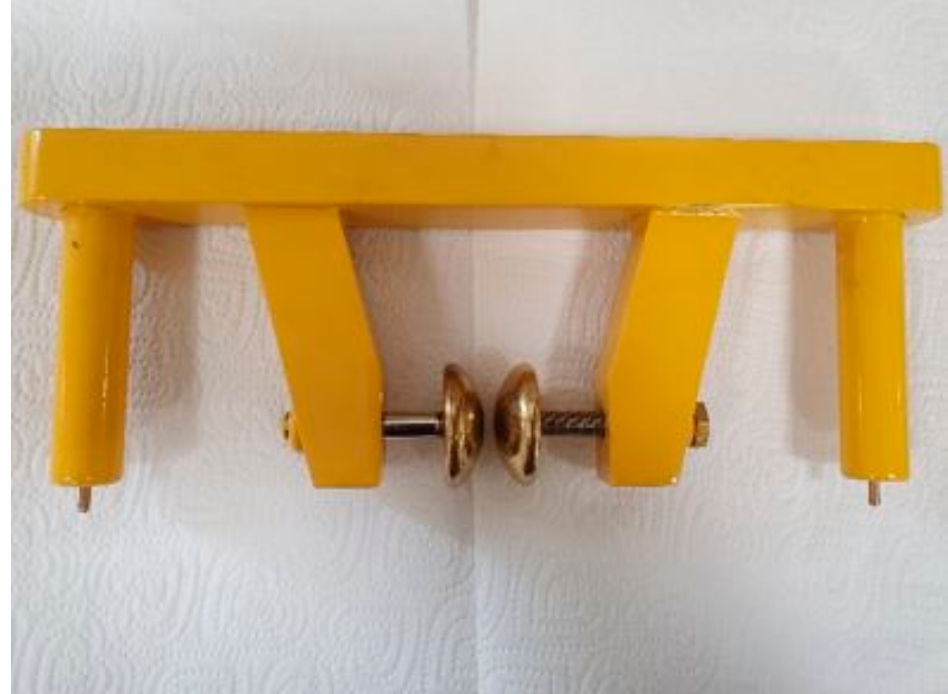
Figure 3. Spherical electrodes used for testing.